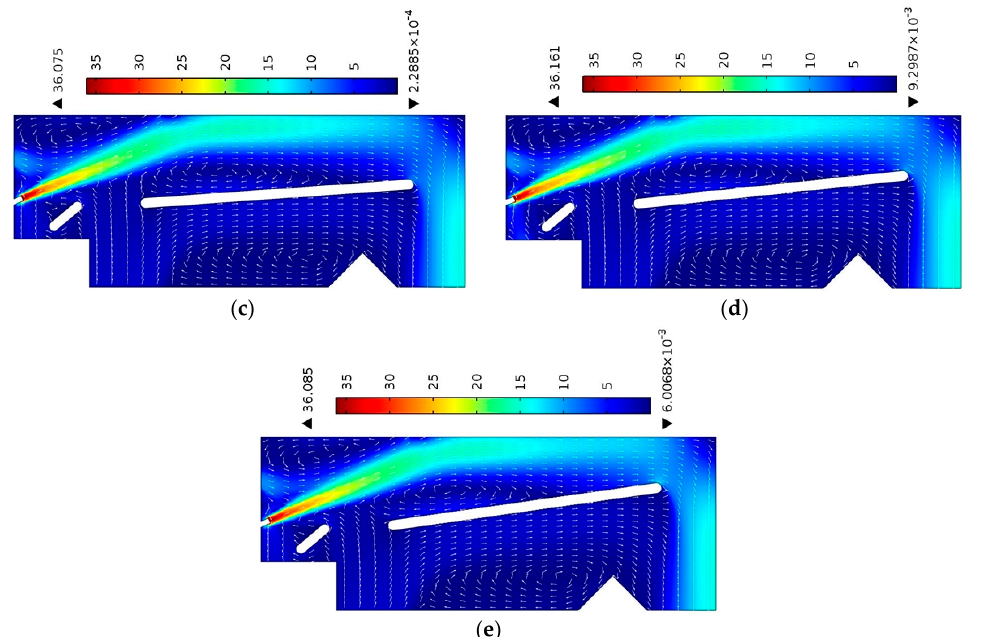
Figure 7. Effect of bed slanting angles ( θ ): ( a ) θ = 0°, ( b ) θ = 2°, ( c ) θ = 4°, ( d ) θ = 6° and ( e ) θ = 8° on the contour and vector plots of velocity magnitude inside the separator model (duct hole diameter = +4 D ) at an air inlet velocity of 35 m/s.